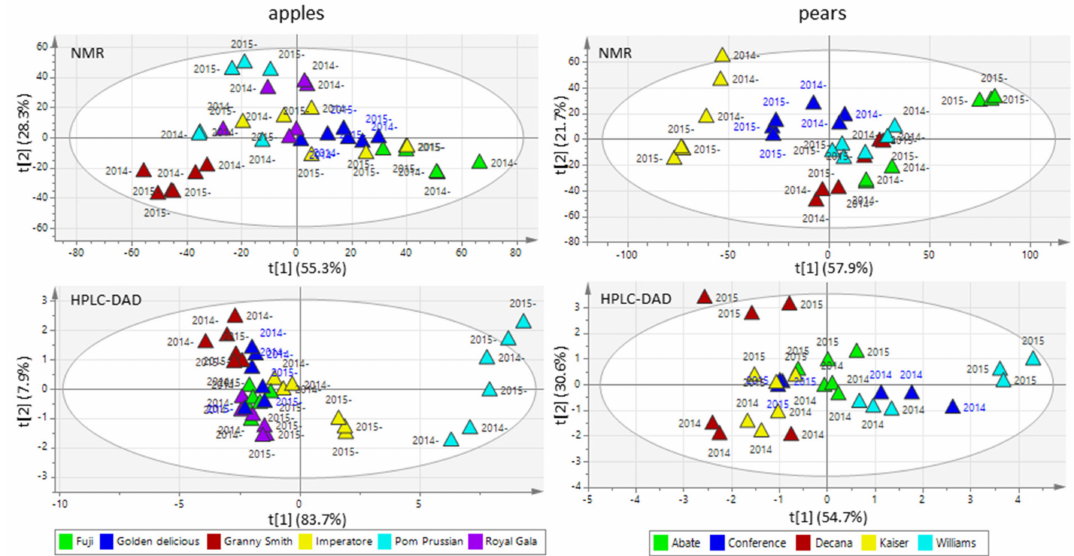
Figure 2. Score plots from the unsupervised PCA of apples ( left ) and pears ( right ) based on quantitative data from NMR ( top row ) and HPLC-DAD analysis ( bottom row